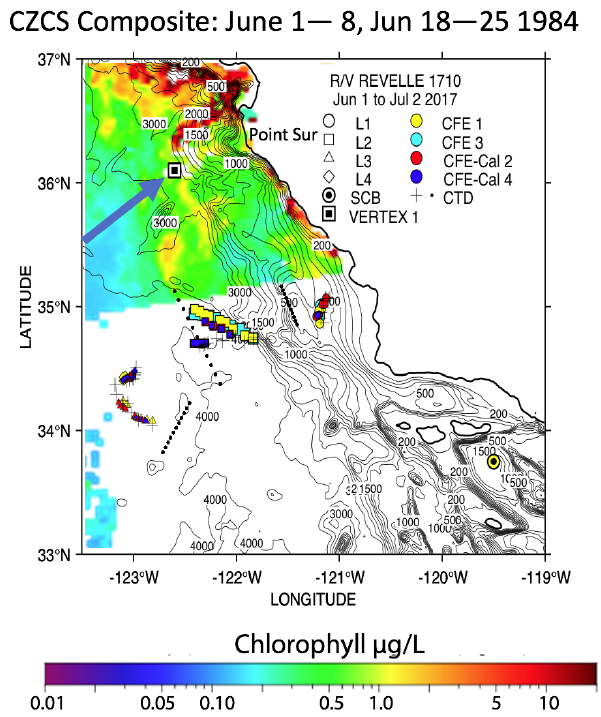
Figure A7. June 1984 composite of Coastal Zone Colour Scanner retrievals of surface chlorophyll which shows a chlorophyll-rich filament in the vicinity of the VERTEX 1 location. The imagery is sparse by modern